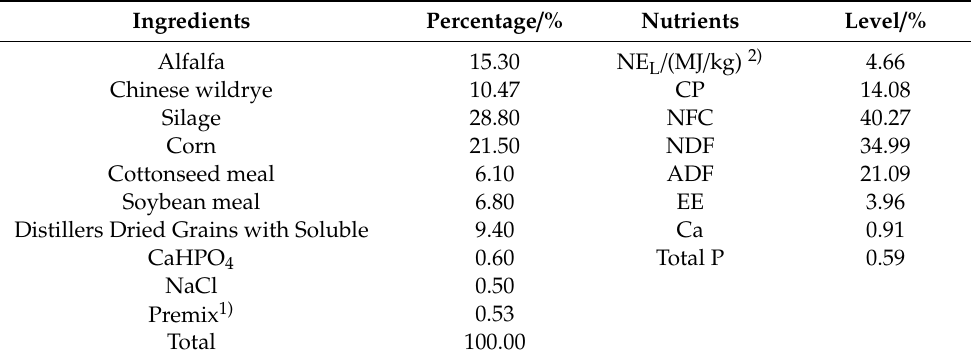
Table 3. Composition and nutrient levels of basal diets (DM